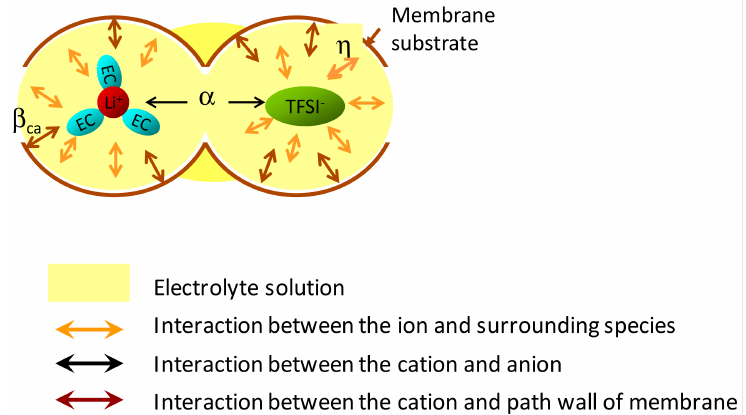
Figure 2. Schematic diagram of interactions on the ions of the solution located in the space of the separator membrane. η ; microviscosity attributed to the van der Waals interaction between the ions (Li(EC) 3+ , TFSI − ) and all surrounding species in the solution (yellow region), α ; microviscosity from the Coulombic interaction between the closest cations and anions (which is a dominant element from the Coulombic interactions), β ca ; microviscosity reflecting the Coulombic interaction between the cations and inside wall of pores (brown barrier) that holds the solution. Reprinted with permission from [24]. Copyright 2017 ACS